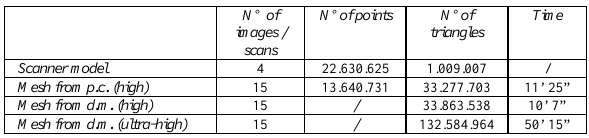
Table 3. Summary of the comparison. Point cloud (p.c.); Depth maps (d.m.)